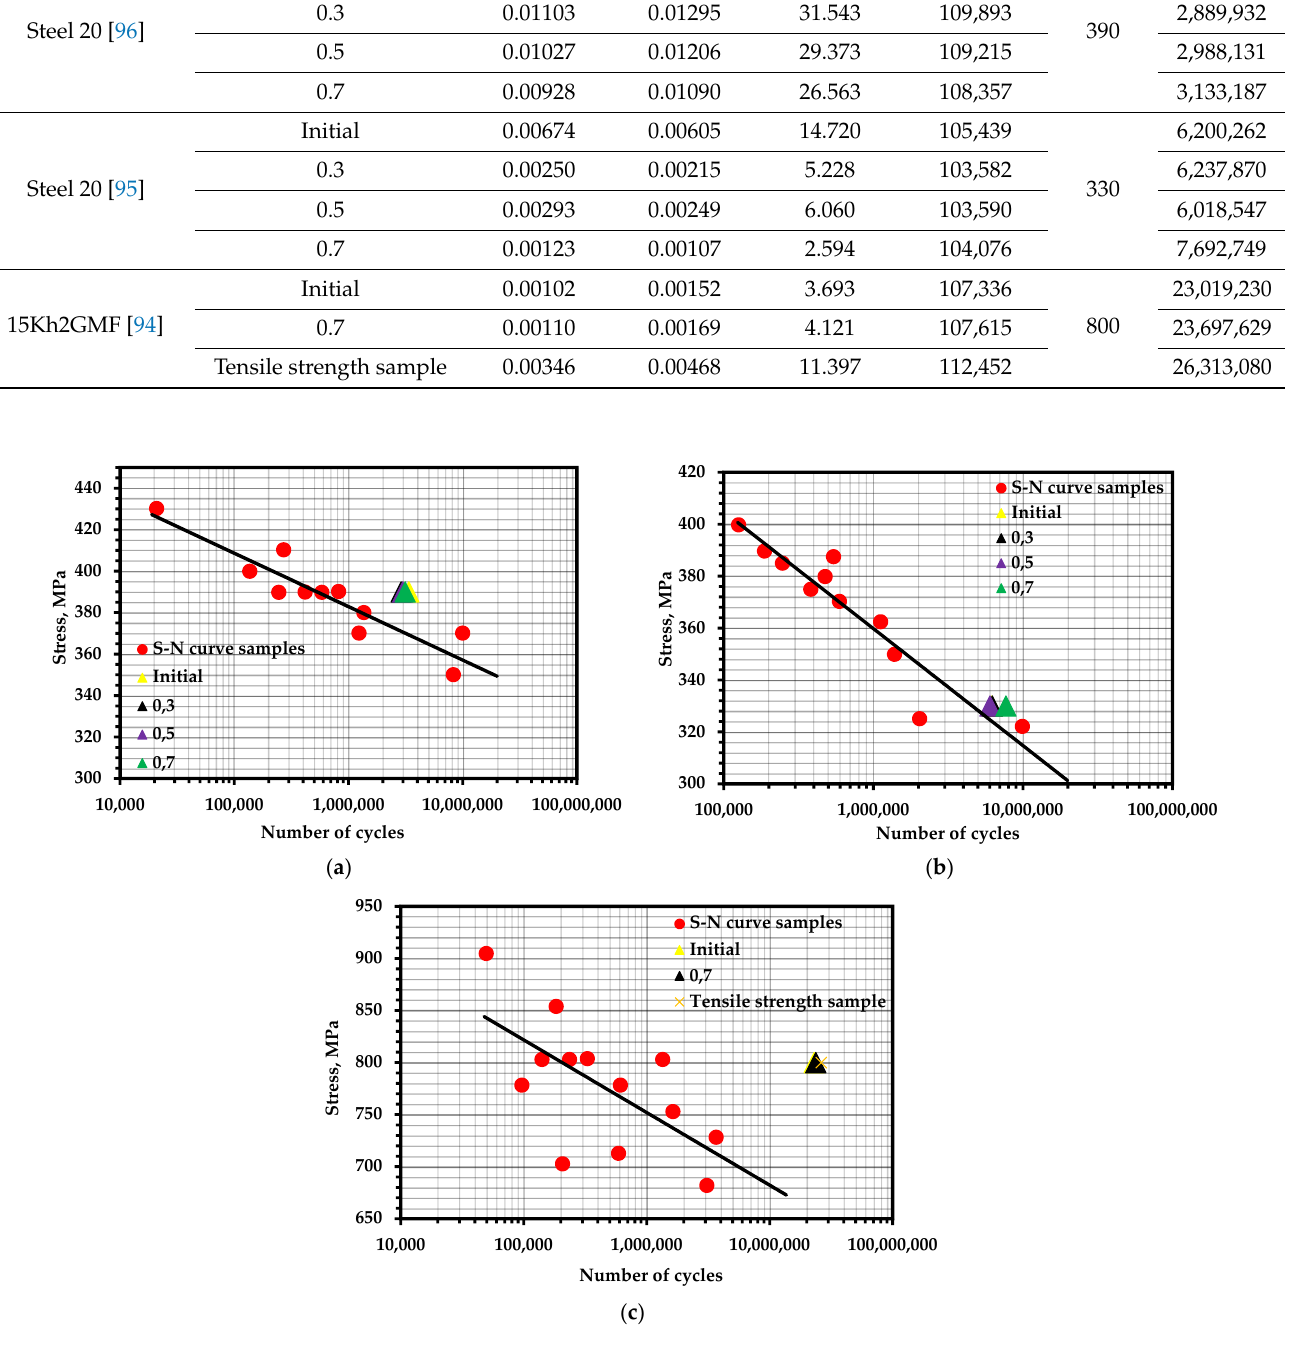
Table 4. Results of fatigue life calculation using concentration-kinetic AE strength indicators.